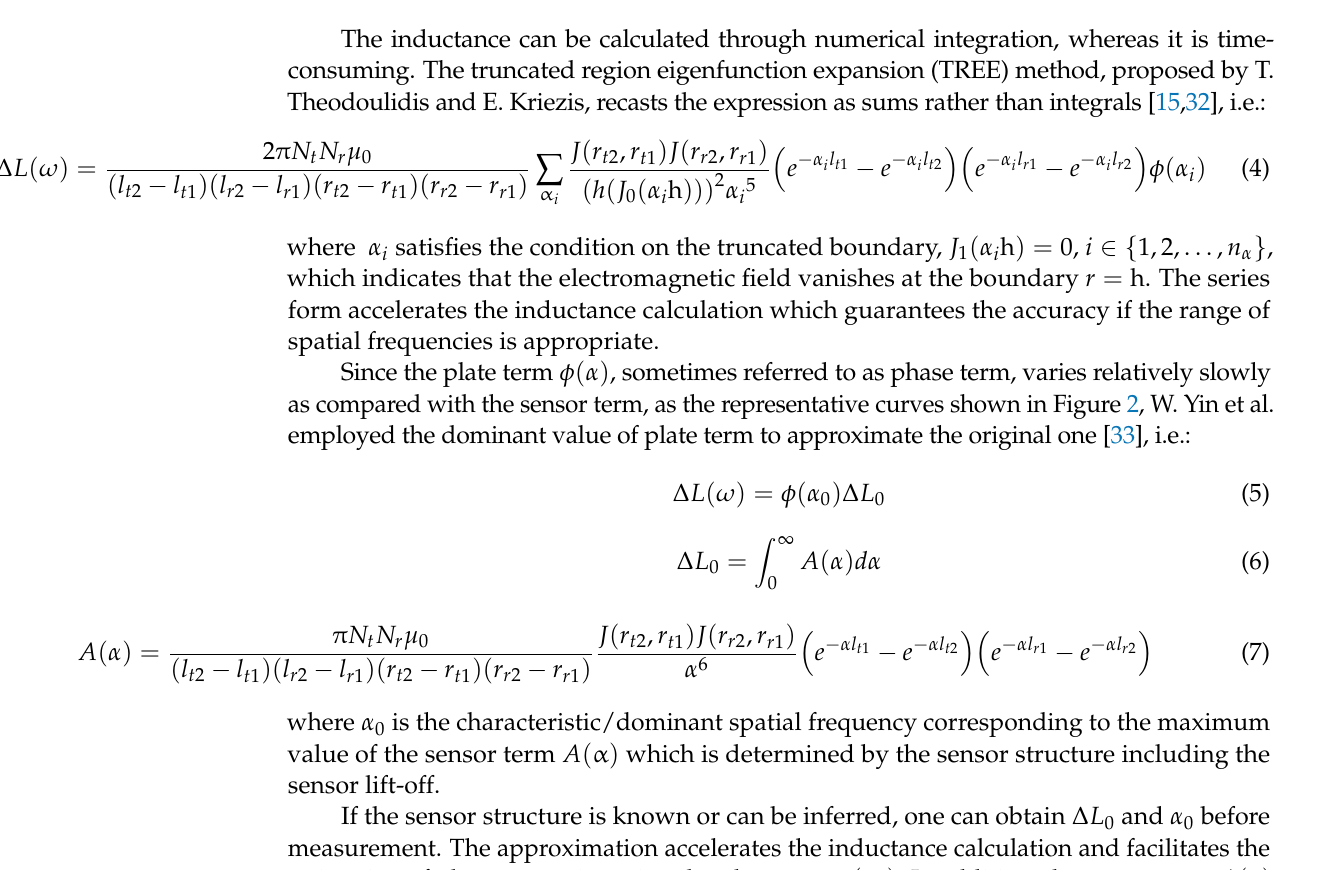
Figure 1. Metallic plate measured using a probe with transmitting and receiving coils.